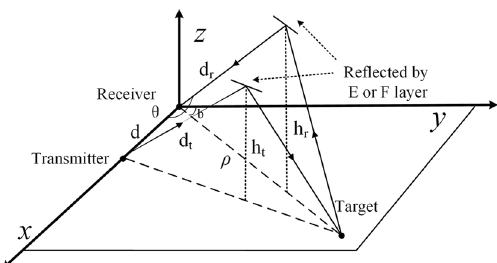
Fig. 5 Transmitter–receiver–target model in